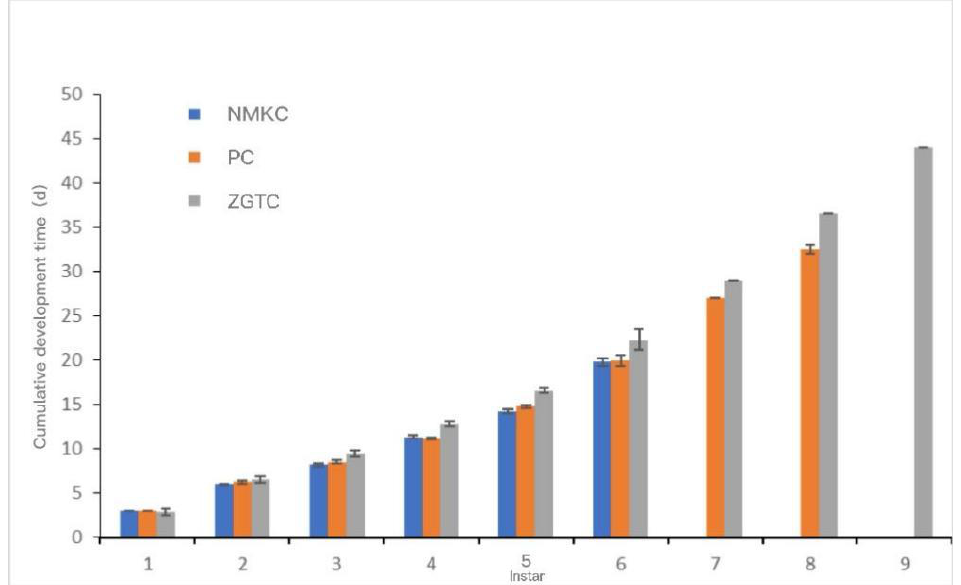
Figure 8. Cumulative development time of Daphniopsis tibetana from different origins.